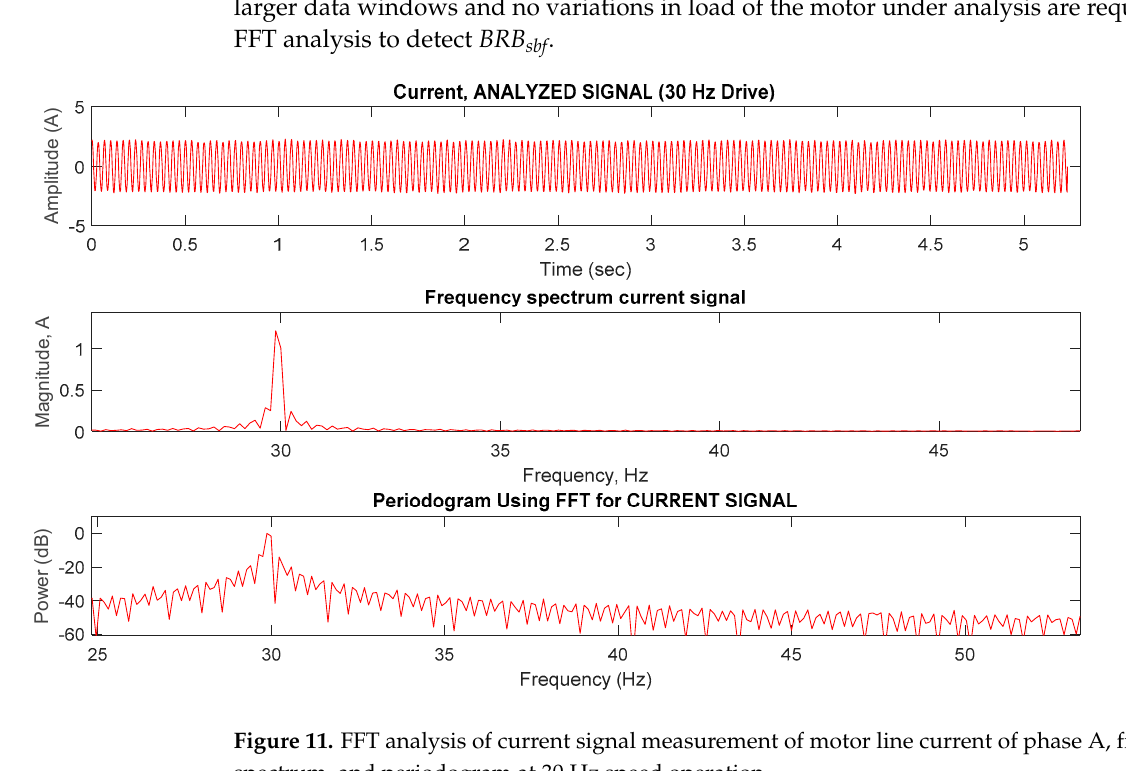
Figure 10. FFT analysis of current signal measurement of motor line current of phase A, frequency spectrum, and periodogram at 40 Hz speed operation.